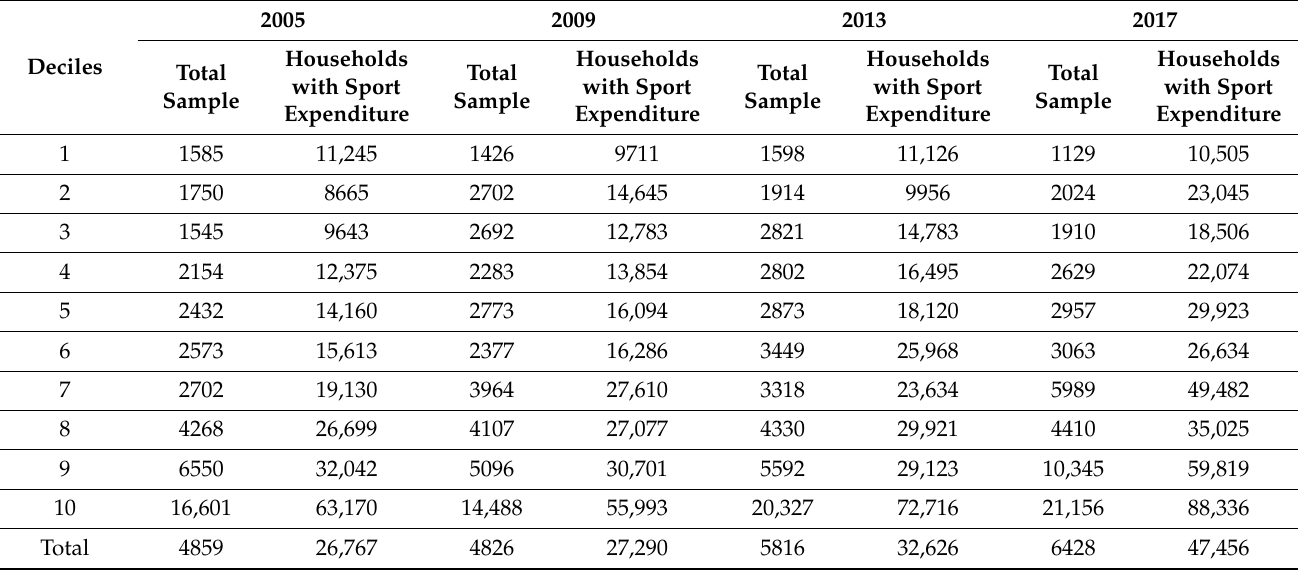
Table 3. Average per capita sports expenditure in the total sample and in the sub-sample of house- holds with sports expenditure